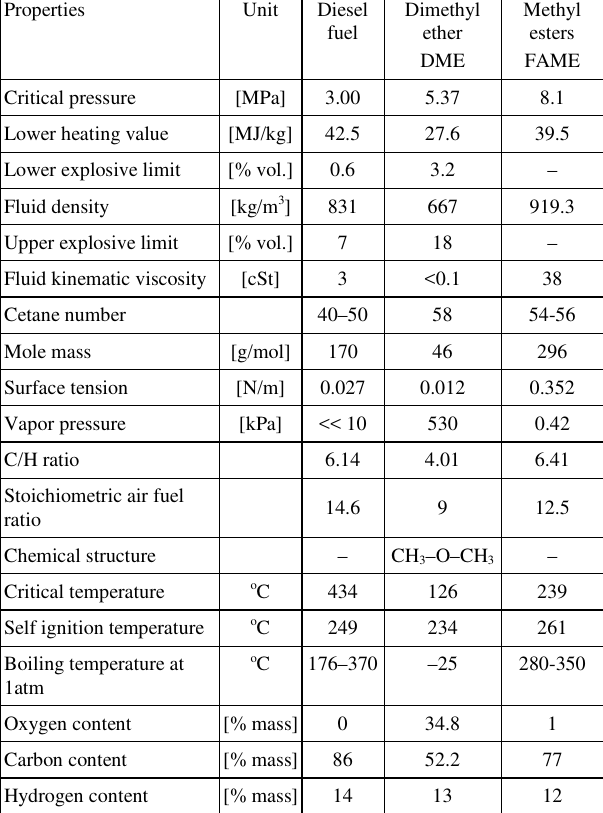
Table 1. Comparison of the properties of dimethyl ether with diesel fuel and fatty acid methyl esters FAME [1, 5, 15, 18]